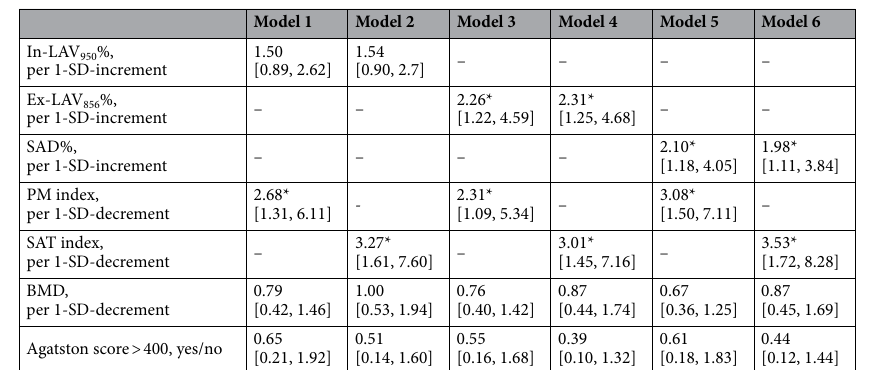
Table 4. Multivariable logistic models to explore associations of CT findings with impaired physical activity in symptomatic patients with COPD (n = 100). Each model was adjusted by age, sex, smoking pack-years, and institution. Impaired physical activity was defined as Life-Space Assessment (LSA) score < 60. All patients met COPD assessment test (CAT) ≥ 10. Values indicate estimate [95% confidence interval]. “- “ indicates no inclusion for a given model. * p < 0.05. In-LAV 950 % = low attenuation volume percentage on inspiratory CT. Ex-LAV 856 % = low attenuation volume percentage on expiratory CT (air-trapping index). SAD% = non-emphysematous air-trapping percentage (small airway dysfunction) on inspiratory/expiratory CT. PM index = cross-sectional area of pectoralis muscle that was normalized by height. SAT index = cross- sectional area of subcutaneous adipose tissue adjacent to pectoralis muscle that was normalized by height. BMD = Thoracic vertebral bone mineral density. Agatston score = coronary artery calcification